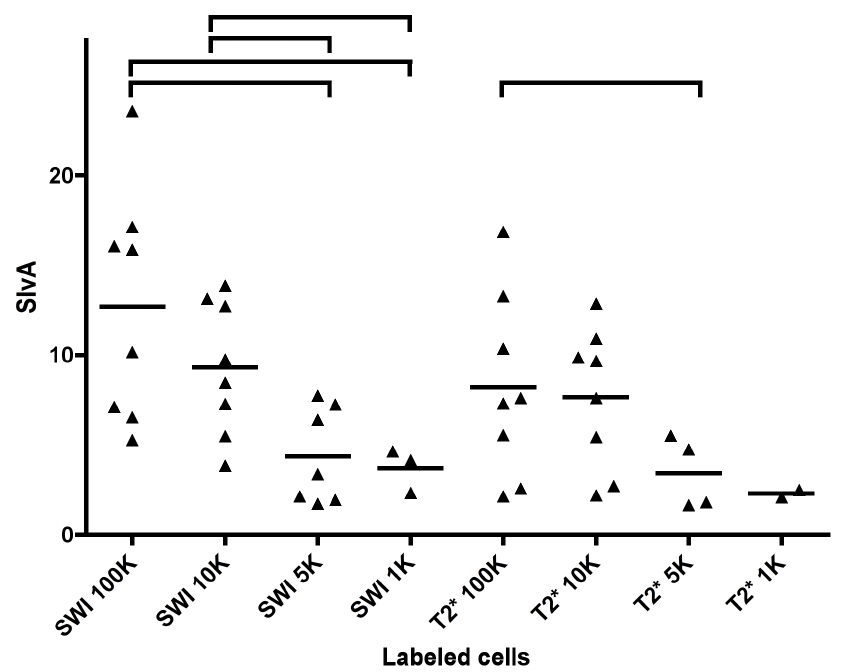
Figure 9. Signal intensity versus artifact-index (SivA). Statistically significant differences (p , 0.05) are indicated by brackets above the data points. Larger amounts of cells per layer generate a higher SIvA indicating a better differentiation between signal drops induced by artifacts and signal drops induced by labeled cells.